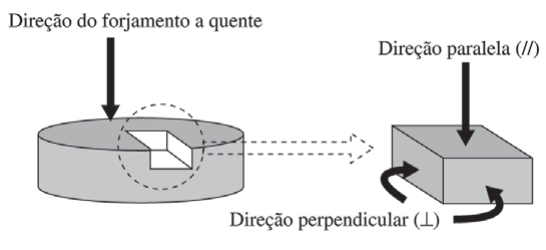
Figura 1. Cortes nas cerâmicas de SBN forjadas a quente.